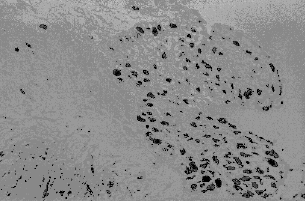
Fig. 4. PCNA expression in cystic pattern of ameloblastoma. Cystic tumour lining shows some tumour cell nuclei with positive results for PC10. ABC method with methyl green counterstain, × 132.